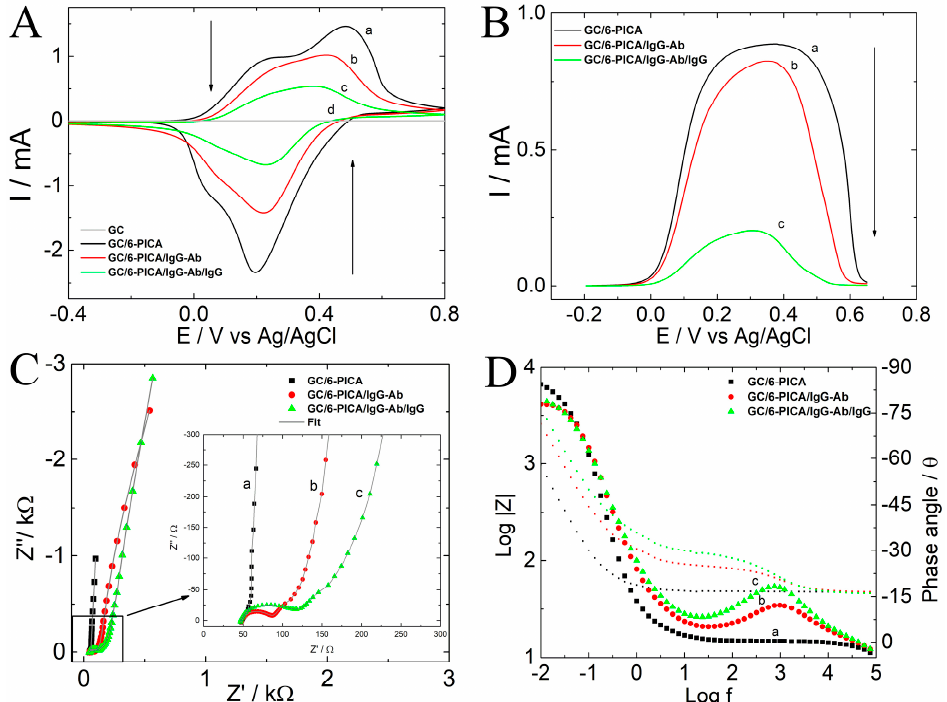
Figure 3. ( A ) CV. Potential scan rate: 0.1 V·s − 1 . ( B ) SWV to the optimized parameters. ( C ) Nyquist and ( D ) Bode plots. EIS: to formal potential, E 0 , 0.01 Hz to 100 KHz, 10 mV of the amplitude of (a) 6-PICA/GCE (black squares), (b) IgG-Ab-6-PICA/GCE (red circles), (c) IgG-Ag-Ab-IgG-Ab-6- PICA/GCE (green triangles), (the concentration of IgG-Ag is 100 ng·mL − 1 ) in acetate buffer (pH 4.75), (d) GCE.